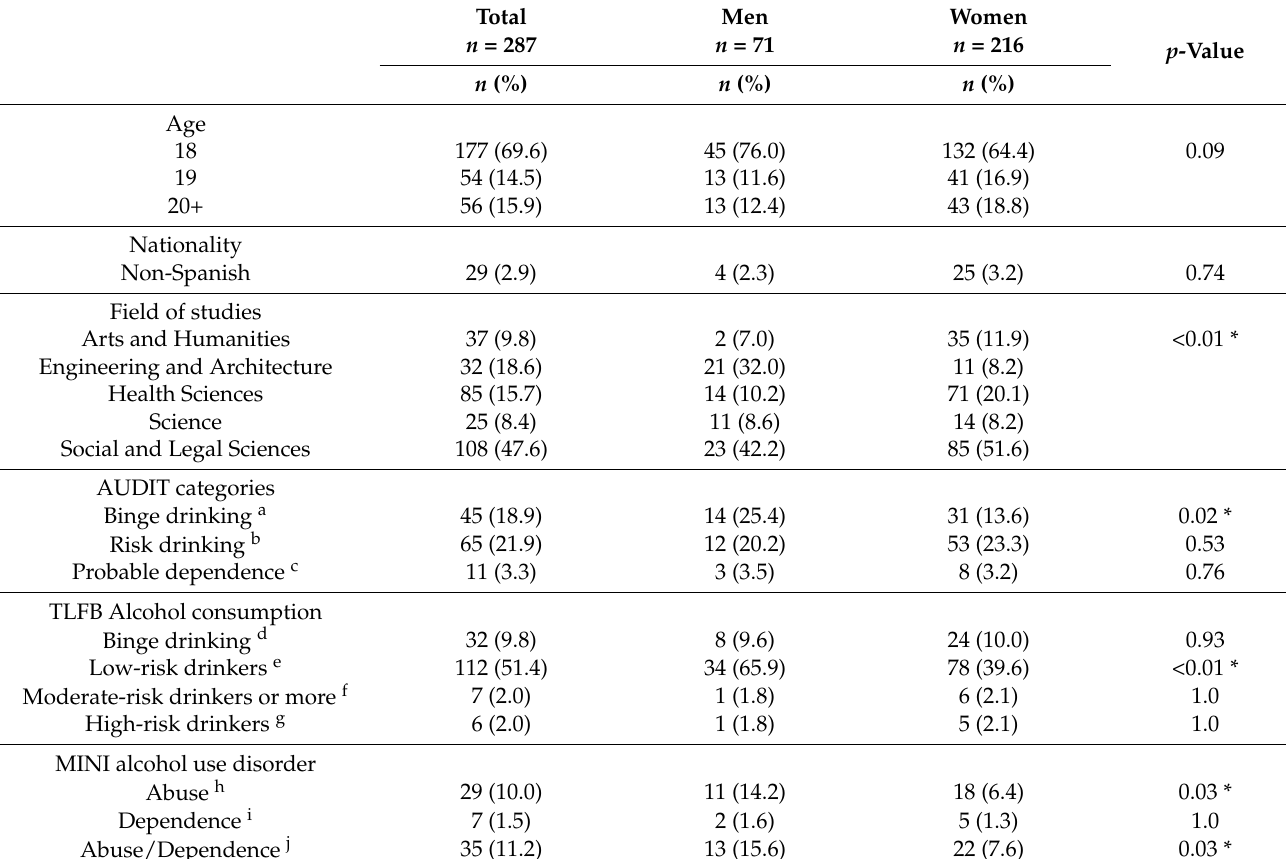
Table 1. Characteristics of the clinical reappraisal sub-sample and prevalence estimates ˆ of alcohol consumption and alcohol use disorder according to the TLFB and the MINI, by gender. (Unweighted observations and weighted percentages.)